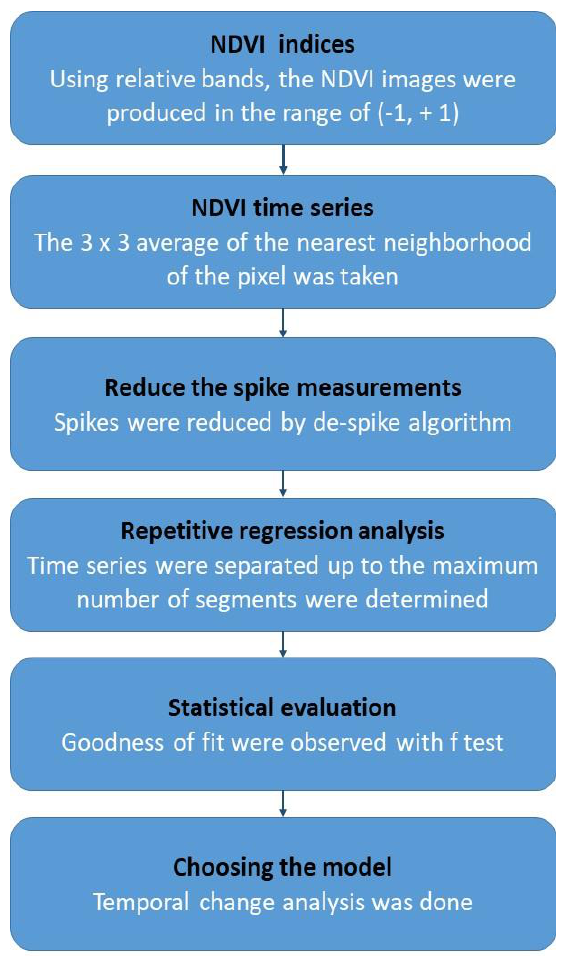
Figure 4. The flowchart of the Landtrendr algorithm used (Toker, 2018). Figure 5. Landtrendr Algorithm results for the first test region, (a) Raw time series, (b) Three different regression models with p values obtained after f statistics test, (c) GEE NDVI time